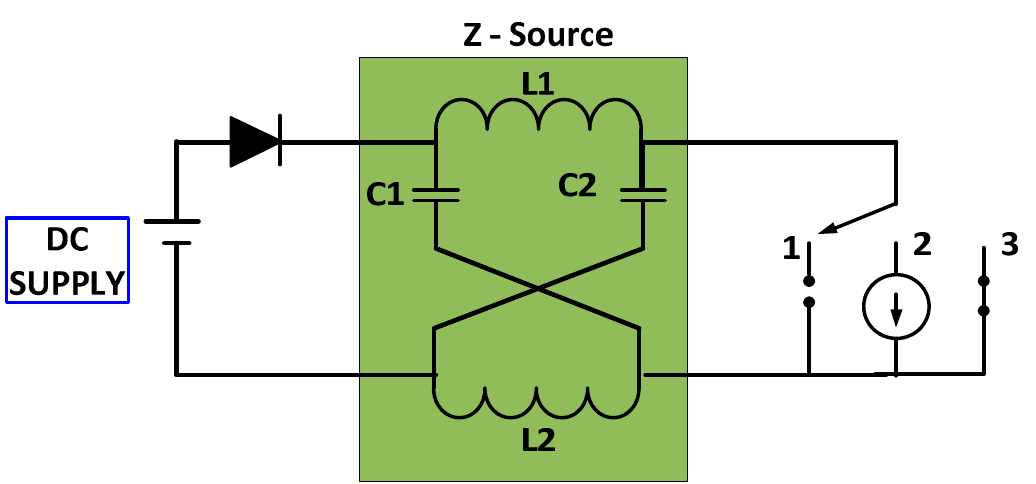
Figure 3. Operating states of the Z-Source DAD converter. (1: open state, 2: active state, 3: shoot-through (ST) state).